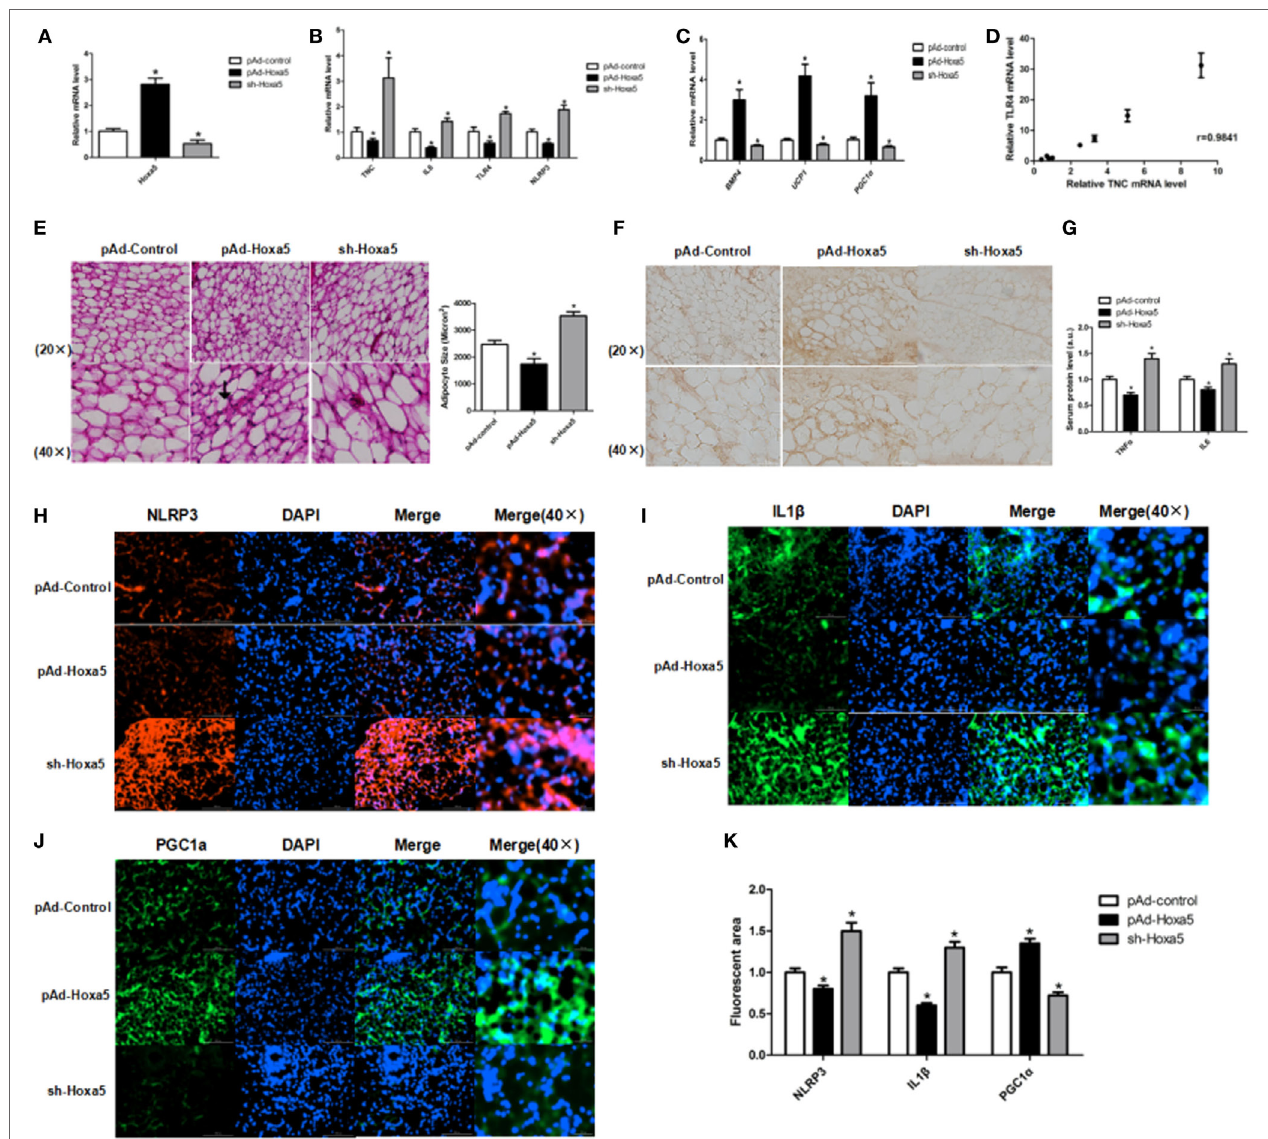
FigUre 2 | Homeobox a5 (Hoxa5) promotes white adipose tissue (WAT) browning and inhibits WAT inflammation in mice. All mice were injected with lipopolysaccharide and cold exposure. (a) Hoxa5 mRNA level of inguinal white adipose tissue (iWAT) in mice ( n = 8). (B) Gene mRNA expression of TNF α , IL6, Toll-like receptor (TLR) 4, and NLRP3 in iWAT ( n = 8). (c) Relative mRNA level of BMP4, UCP1, and PGC1 α in mice iWAT in different groups ( n = 8). (D) Correlation analysis of TLR4 and tenascin C (TNC) mRNA level in mice iWAT ( n = 10). (e) Adipocyte size was monitored in frozen-section iWAT samples by hematoxylin-eosin staining ( n = 8). (F) Images of immunohistochemical staining of iWAT in different groups. (g) Serum levels of TNF α and IL6 in different groups ( n = 6). (h–J) Images of iWAT stained by immunofluorescent staining in different groups ( n = 4). (K) Quantitate of immunofluorescent staining in Figures 3h–g . Values are represented as means ± SD vs. control group, * p <